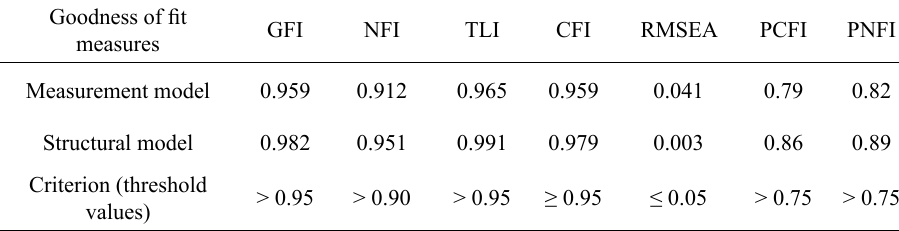
Table 5. Models fit statistics